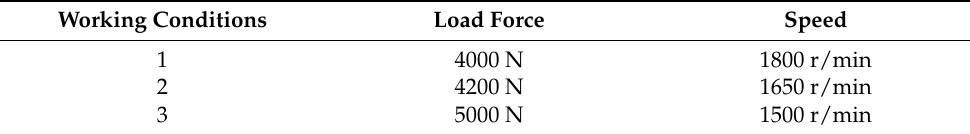
Figure 6. Overview of PRONOSTIA. Table 1. Three working conditions of the PHM2012 dataset. Table 1. Three working conditions of the PHM2012 dataset.